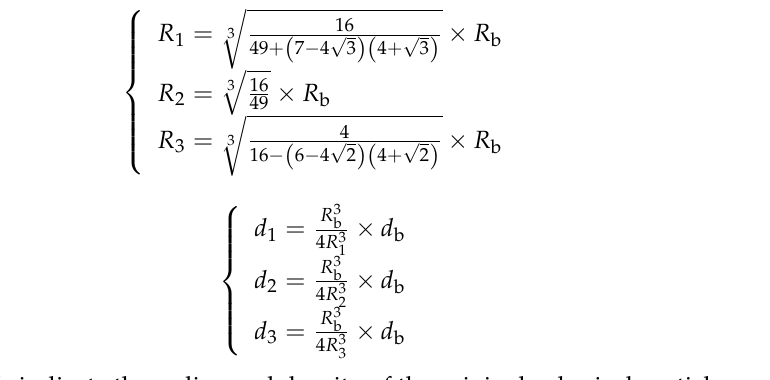
where R b and d b indicate the radius and density of the original spherical particle, respec- tively; R 1 , R 2 , and R 3 are the radius of the diamond-like, triangle-like, and square-like sub-particles, respectively; d 1 , d 2 , and d 3 represent the density of the diamond-like, triangle- like, and square-like sub-particles, respectively. The long axes of the cluster particles are randomly